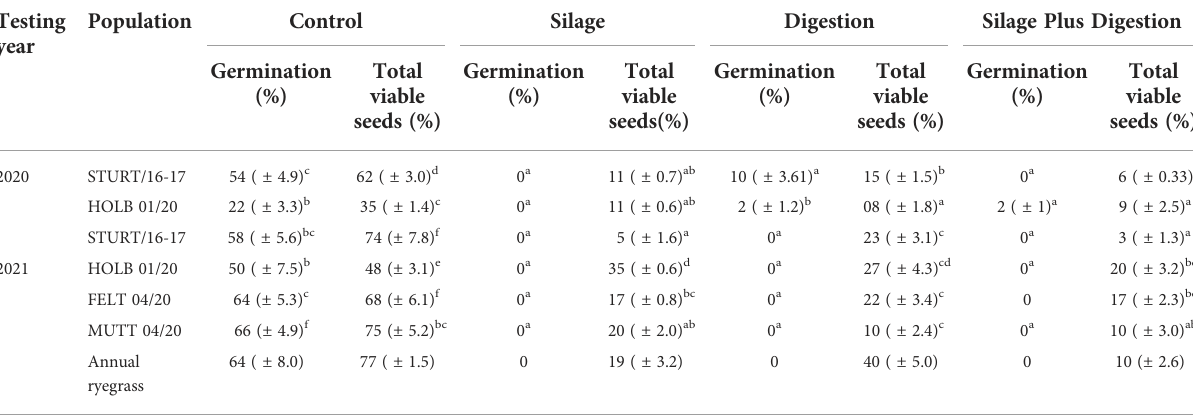
TABLE 2 Seed germination and viability of four different populations of feathertop Rhodes grass after four different seed-damaging